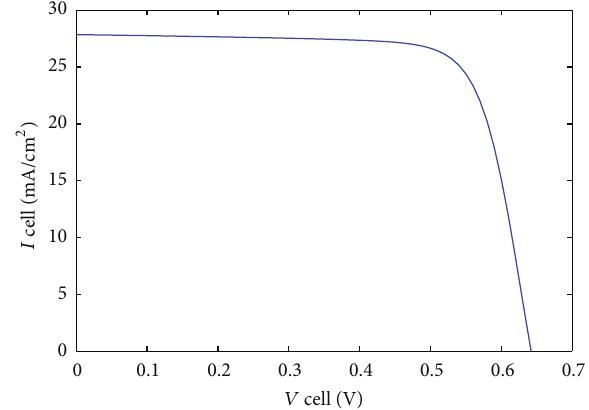
Figure 7: 𝐼 - 𝑉 curve (per cm 2 ) a simulated CIGS solar cell.